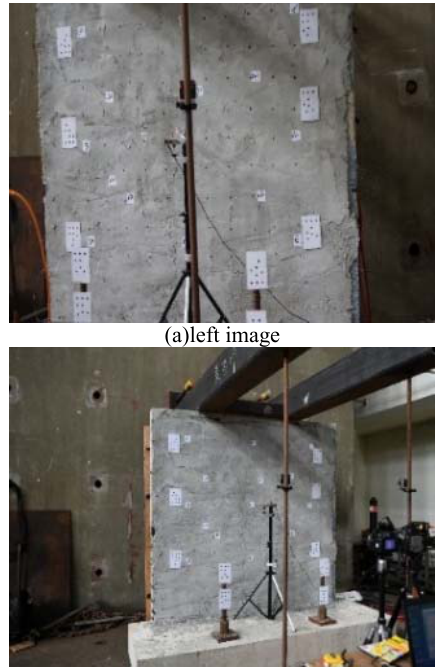
Figure 2. Images from two cameras